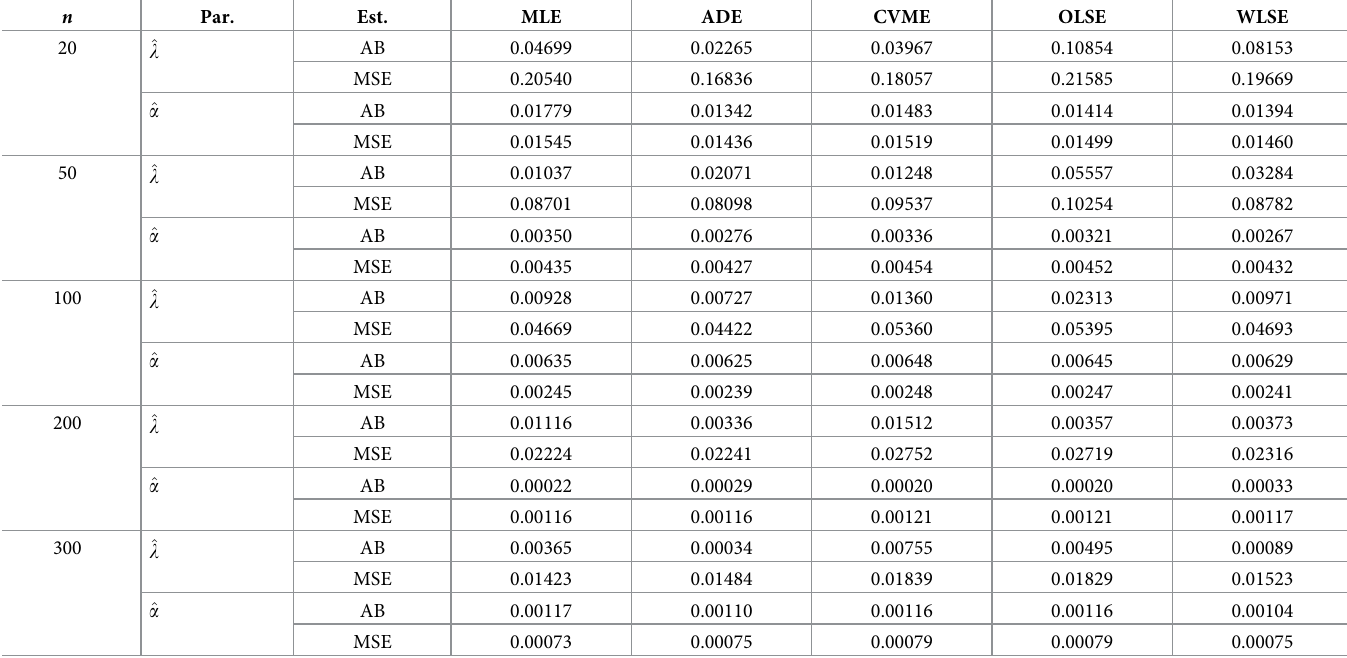
Table 4. Simulation results for ( λ = 0.5, α = 0.5). n